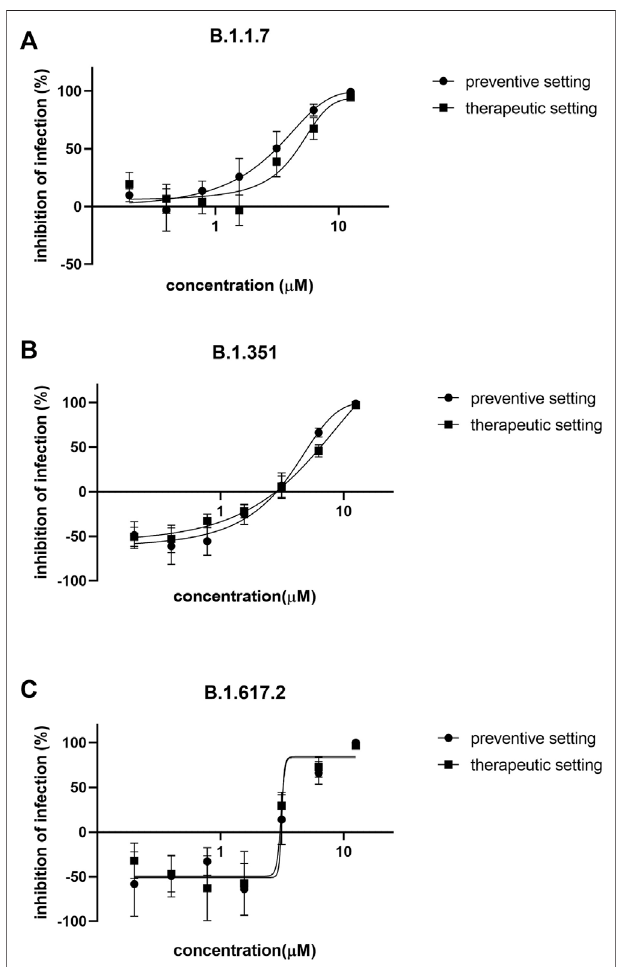
FIGURE 4| Azelastine iseffective against the major variants of concerns inVero-TMPRSS3/ACE2cells.Vero-TMPRSS2/ACE2cellswereinfectedwith (A) B.1.1.7 (B) B.1.351 or with (C) B.1.617.2 variant of SARS-CoV-2 simultaneously with or 30 min prior to the addition of 0.4 – 12.5 µM of azelastine. After 48 h, RNA was extracted from the culture supernatant and was quanti fi ed by qPCR analysis. Graphs show percent inhibition of infection based on viral genome counts relative to virus only control expressed as mean ± SEM from 3 independent experiments, each with 3 technical replicates.